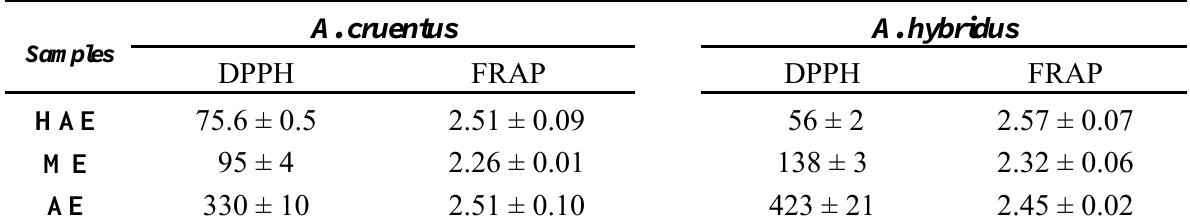
Table 5. DPPH • scavenging and iron III reducing